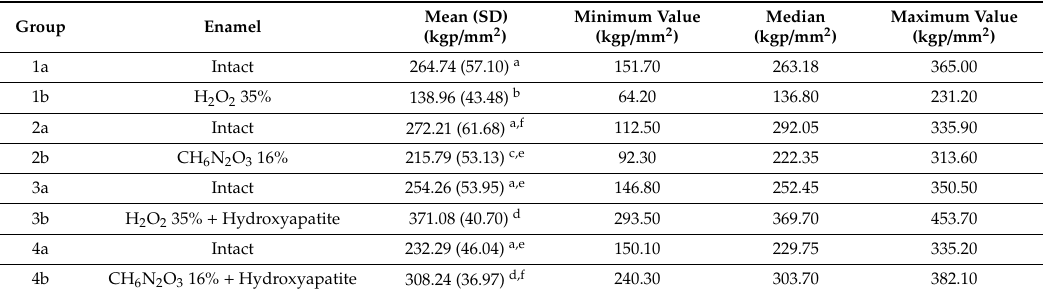
Table 2. Descriptive statistics (Vickers Hardness number (VHN)) of the di ff erent